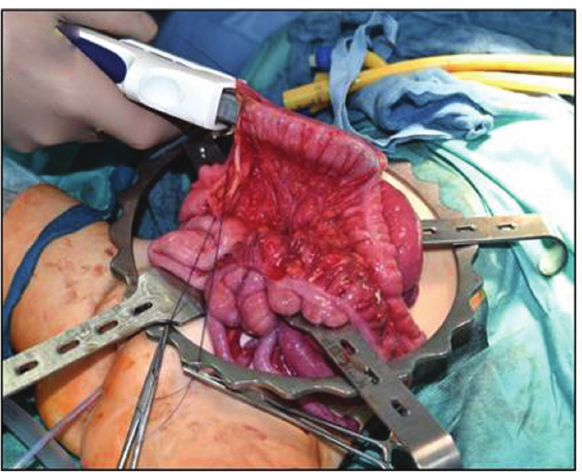
Fig. 4 Division of the common colonic wall using a stapler to create one lumen up to the level of the ileocaecal valve.